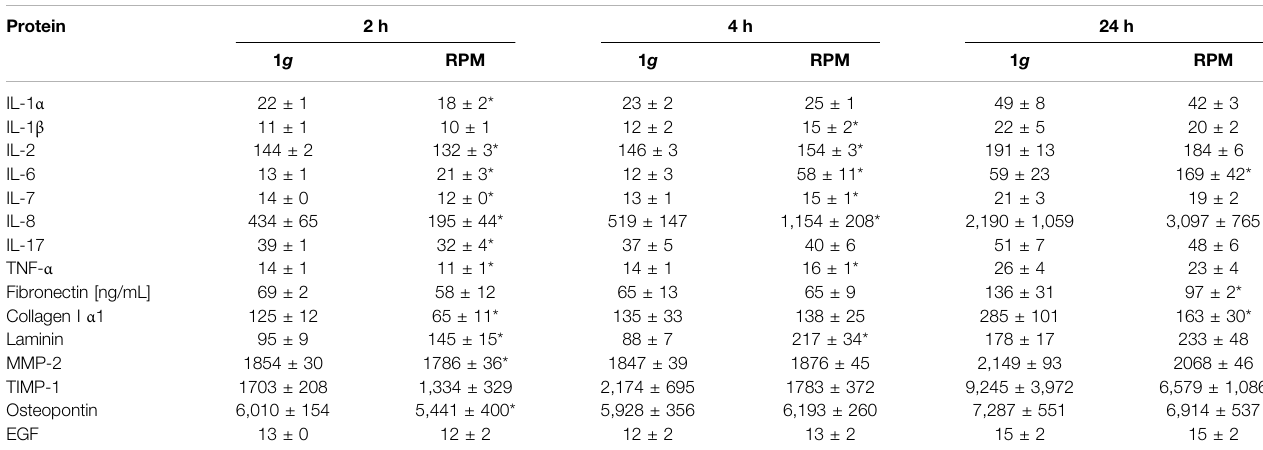
TABLE 3 | Secreted proteins of PC-3 cells [pg/mL]. n = 5; * p < 0.05 vs. 1 g . Protein